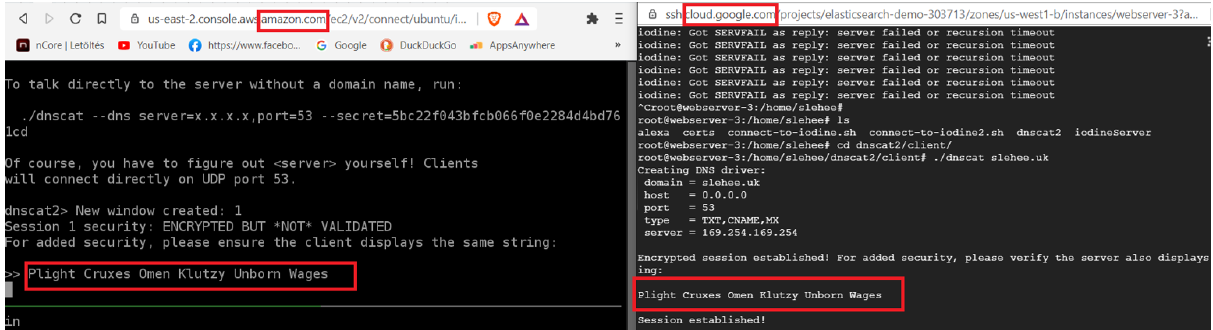
Figure 7. DNS tunnelling connection established by utilising